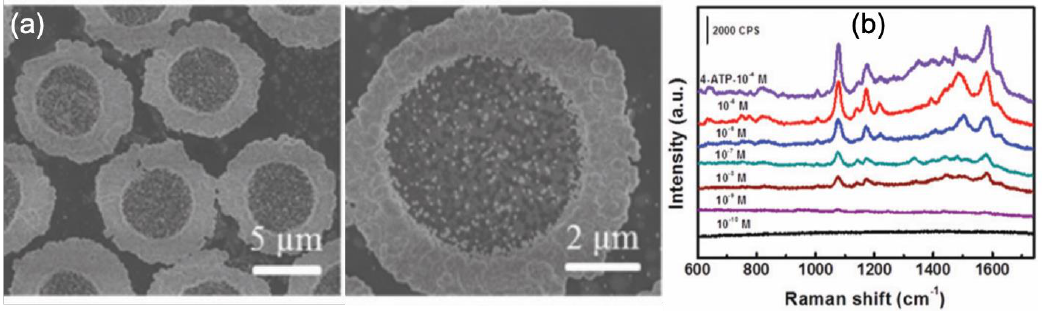
Figure 2. ( a ) SEM images of the obtained Pt disks decorated by gold micro-rings. ( b ) SERS spectra of 4-ATP molecules for different concentrations. All the figures are reproduced from [75] with permission from the Royal Society of